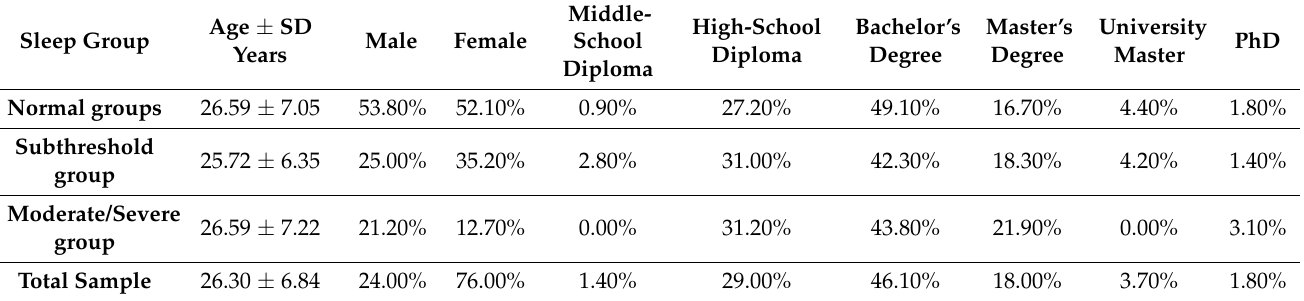
Table 1. The demographic information for each sleep group created on the basis of individual ISI scores is